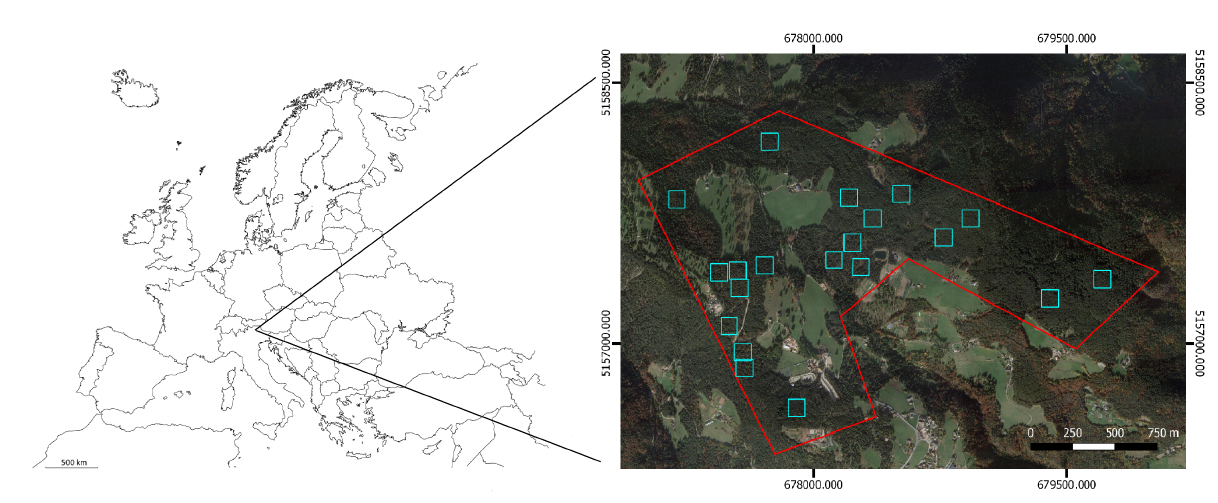
Figure 1. Study area of San Genesio/Jenesien (Italy). The the blue squares identifies the position of the plots (100 × 100 m each). The red line shows the area where the plots have been randomly selected.